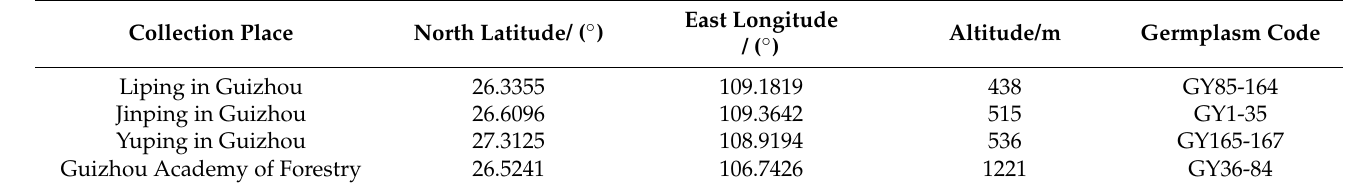
Table 1. Information about the 167 C. oleifera germplasm samples